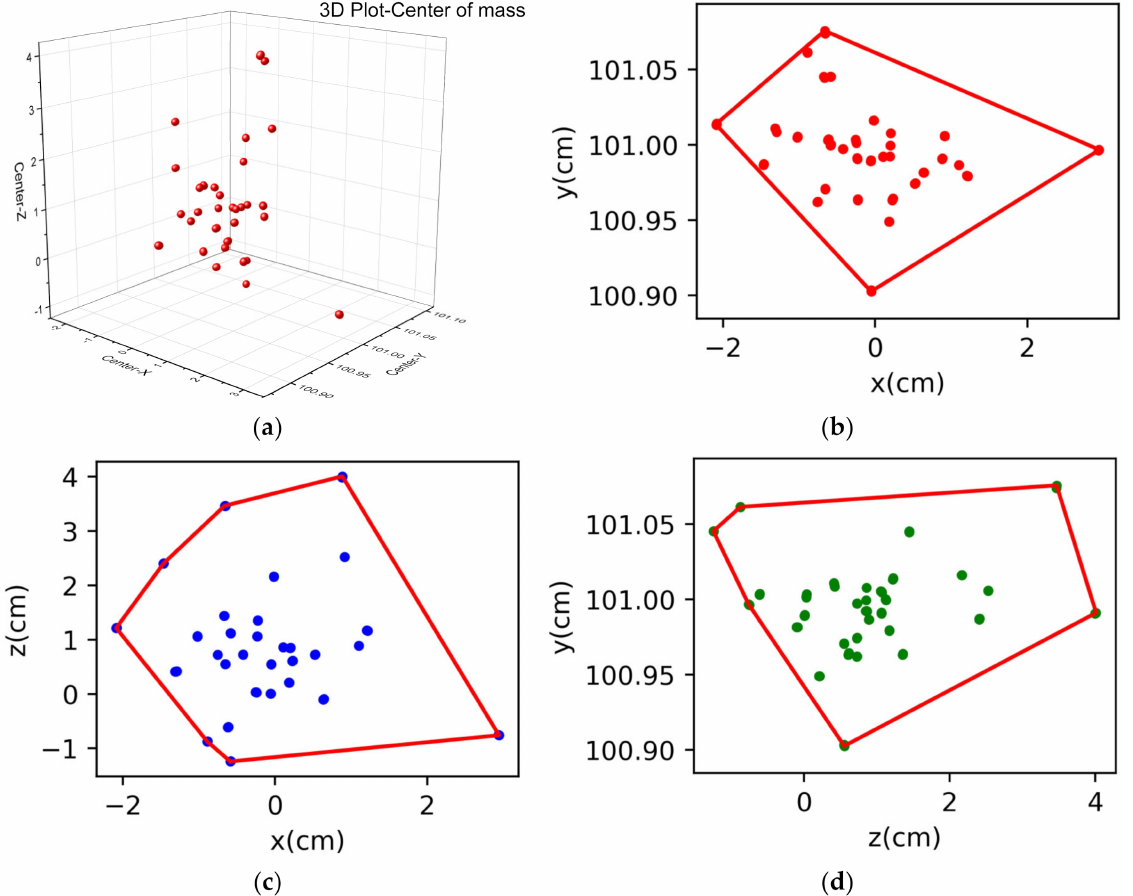
Figure 8. ( a ) The 3D scatter of the mass center of the last three frames. ( b ) The convex hull graph distribution of projection on the XY axis. ( c ) The convex hull graph distribution of projection on the XZ axis. ( d ) The convex hull graph distribution of projection on the YZ